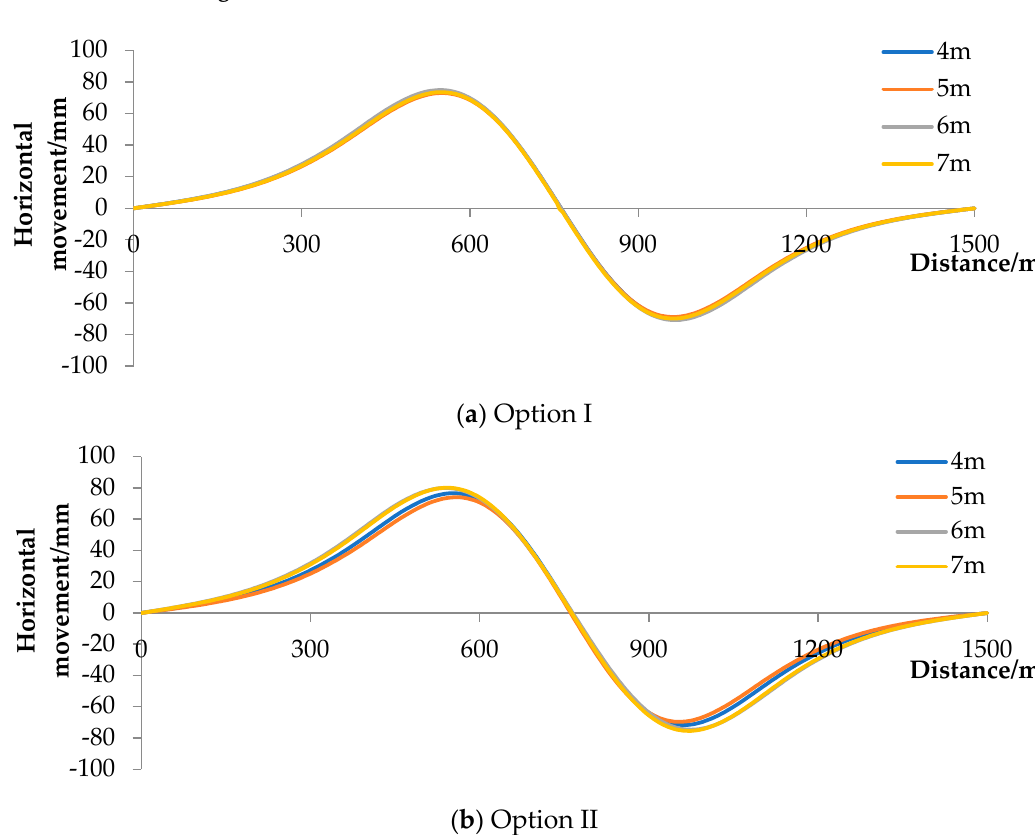
Figure 18. Surface subsidence curve.